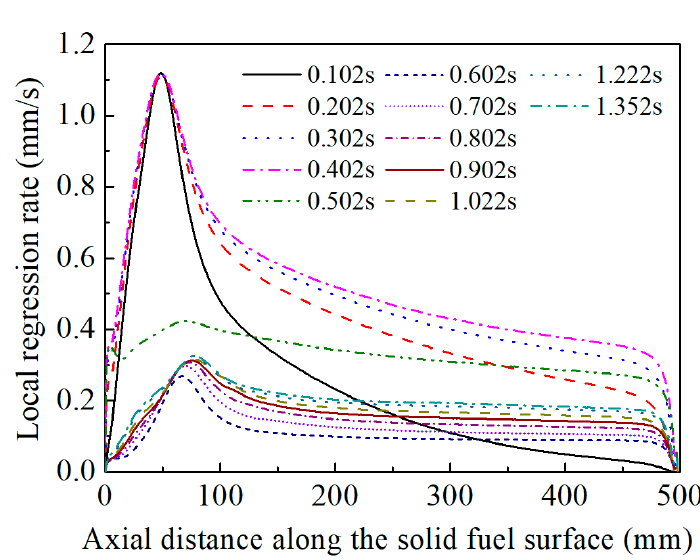
Figure 20. The local regression rate of different time.